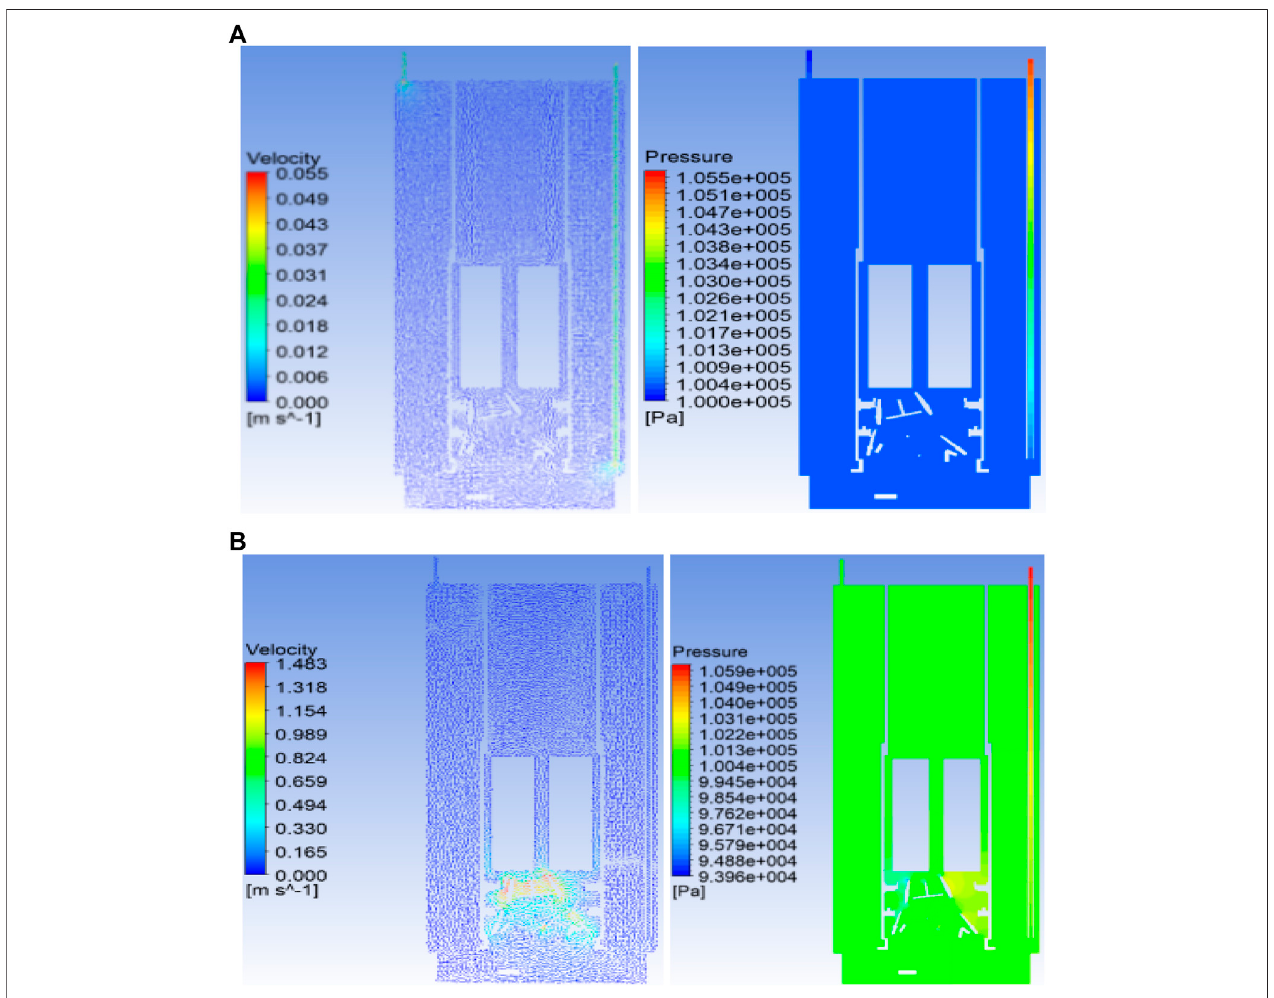
FIGURE 10 | Velocity fi eld and pressure fi eld of OLTC. (A) Velocity fi eld and pressure fi eld before action. (B) Velocity fi eld and pressure fi eld before arcing.